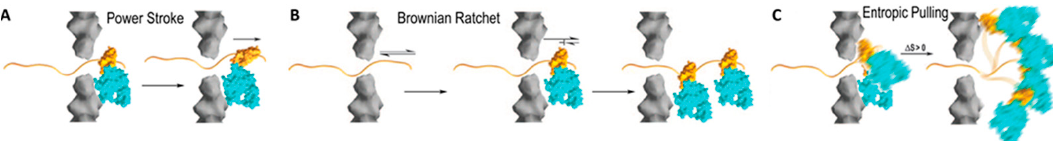
Figure 1. Different models for Hsp70 motor action in the context of protein translocation through an import channel. ( A) Power-Stroke. Hsp70 (in cyan and yellow) binds the translocating protein (yellow) and a site on the import channel (grey). Coincident with a step in its ATP hydrolysis cycle it undergoes a conformational change that generates a directed pull on the protein. ( B ) Brownian ratchet. An unfolded polypeptide can slide back and forth in the channel but Hsp70 binding on one side blocks backwards sliding. Repeated cycles of such sliding and Hsp70 binding can eventually move the entire protein through the channel. ( C) Entropic pulling. Loading of Hsp70 onto the translocating protein close to the import channel restricts Hsp70 freedom of motion. Movement of the Hsp70 away from the channel increases its motional freedom and entropy, generating an entropic pull on the translocating protein. Adapted from ref. [13].